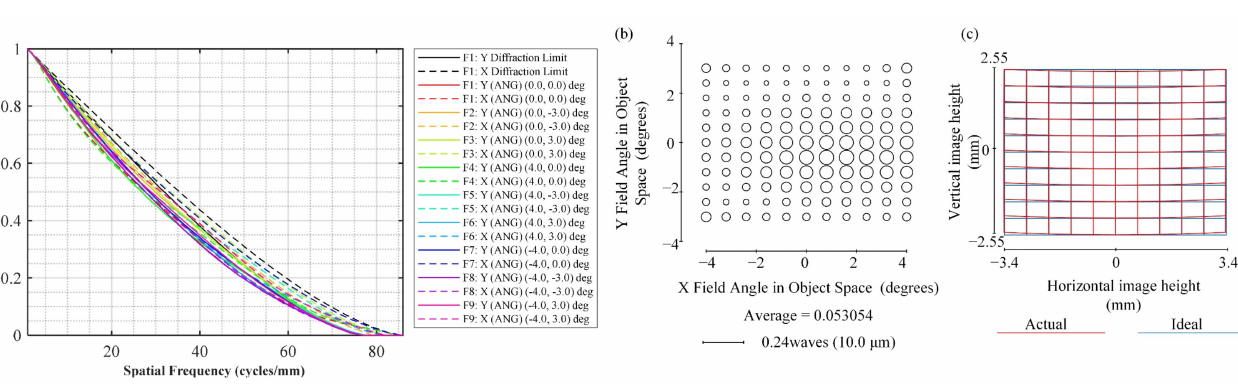
Figure 7. The layout of the optimized nonsymmetric off-axis three-mirror system. ( a ) The system layout of YZ view. ( b ) The system layout of XZ view. ( c ) Three-dimensional view from − 40 ◦ azimuth angle and 20 ◦ elevation angle, with M1 as a reference. ( d ) Three-dimensional view from − 38 ◦ azimuth angle and 27 ◦ elevation angle, with M1 as a reference.